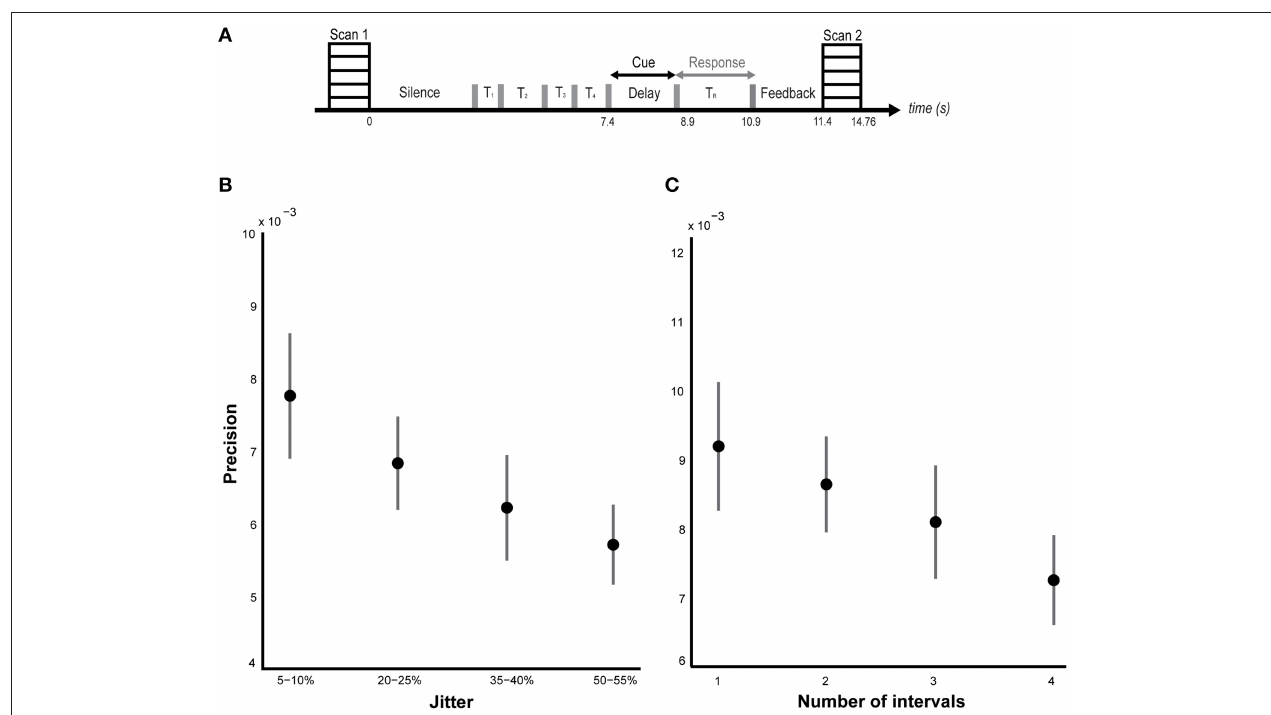
FIGURE 1 | Behavioral results. (A) Task and sparse imaging paradigm. Listeners are presented with a sequence of time intervals (4 intervals in the jitter condition and 1–4 intervals in the number-of-intervals condition) separated by clicks (indicated by the gray bars). At the end of the sequence, a probe is presented during the delay period (2 s) indicating the interval to be reproduced. Another click is played after the delay indicating the start of the reproduction interval which listeners are required to terminate at a point in time that corresponds to their memory of the probed interval. Feedback, equal to the difference between the reproduced interval and the actual duration of the probed interval is presented for 500 ms at the end of each trial. The task structure and timing is shown between two successive volumes in the sparse imaging design. (B) Performance on jitter blocks . Listeners’ performance ( n = 18) was calculated as the precision of the timing error distribution. The mean precision ( ± SEM) is plotted as a function of temporal regularity, varying from 5–10% jitter to 50–55% jitter as indicated on the x-axis. A significant effect of jitter ( p = 0.02) on precision was observed (see results). (C) Performance on number of intervals blocks. Listeners’ ( n = 16) mean precision ( ± SEM) is plotted against the number of intervals on the abscissa. No significant effect of memory load ( p = 0.36) was found (but see results).